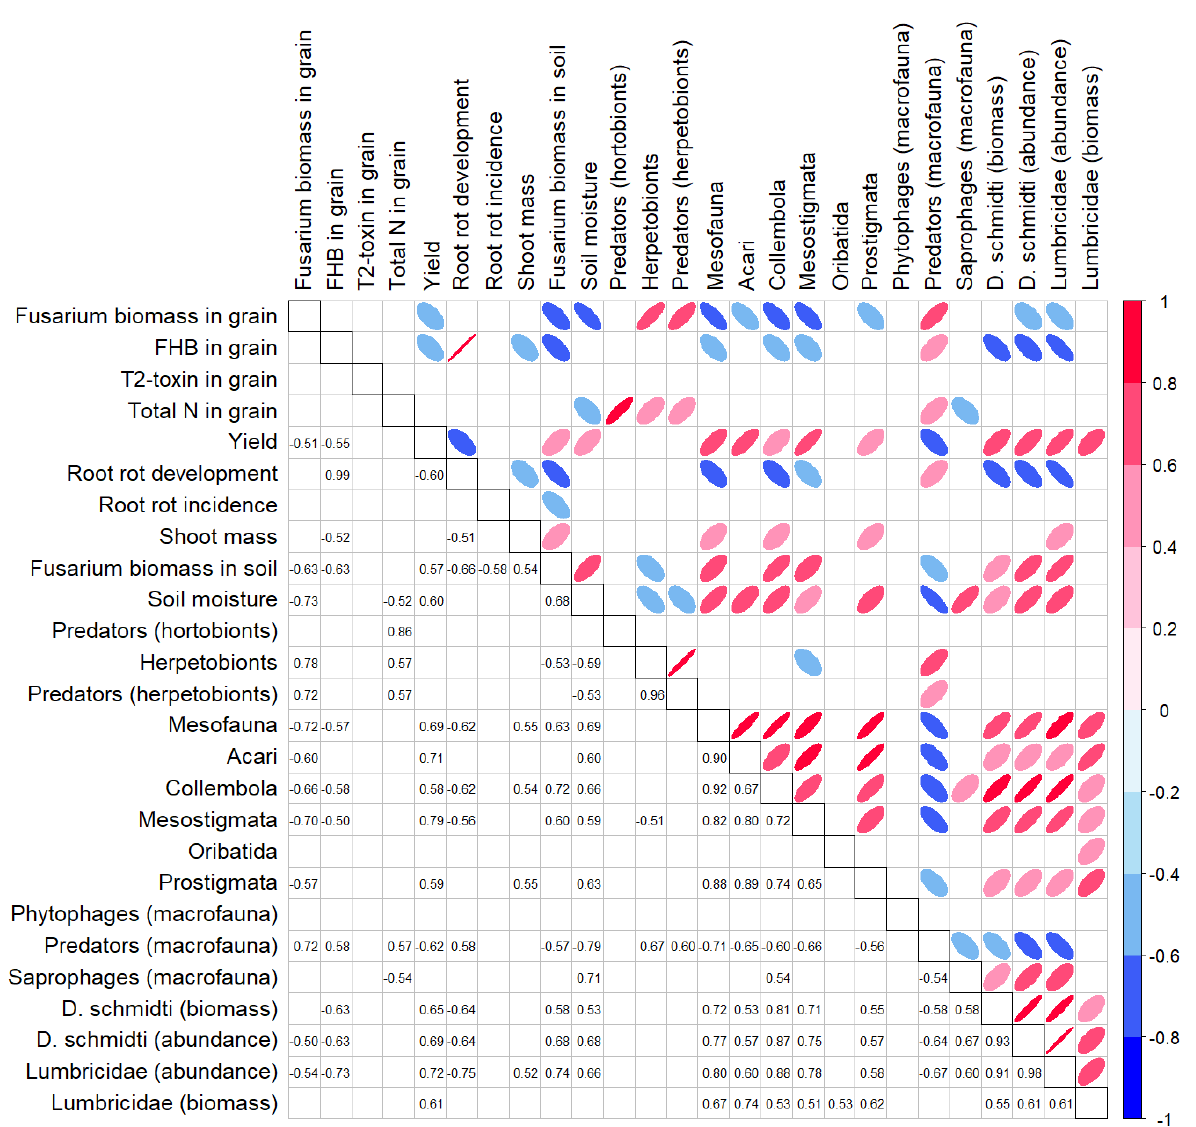
Figure 4. Pearson correlation matrix of five FHB related study endpoints and 21 ecosystem parameters included in the primary analysis. Only significant correlations are shown ( p < 0.05). Correlation coefficient values are shown on the lower matrix triangle. Upper triangle: ellipses oriented from top left to bottom right represent negative correlation coefficient and vice versa. Smaller ellipse width represents a larger correlation coefficient value.